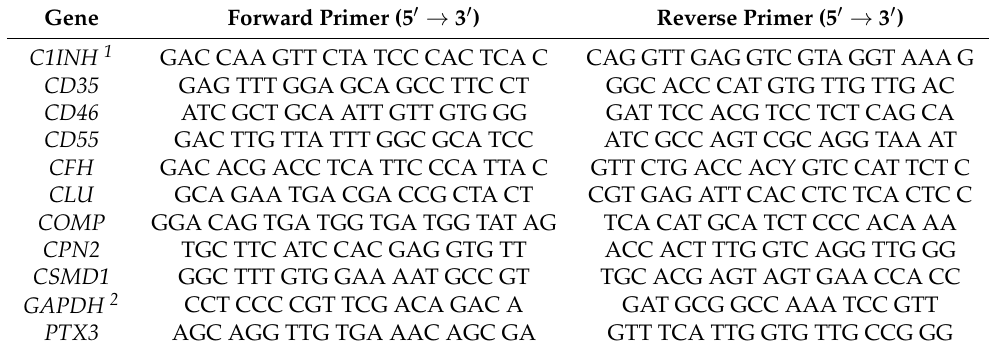
Table 3. Pig PCR primer sequences designed using NCBI PrimerBlast. Gene Forward Primer (5 (cid:48) → 3 (cid:48)